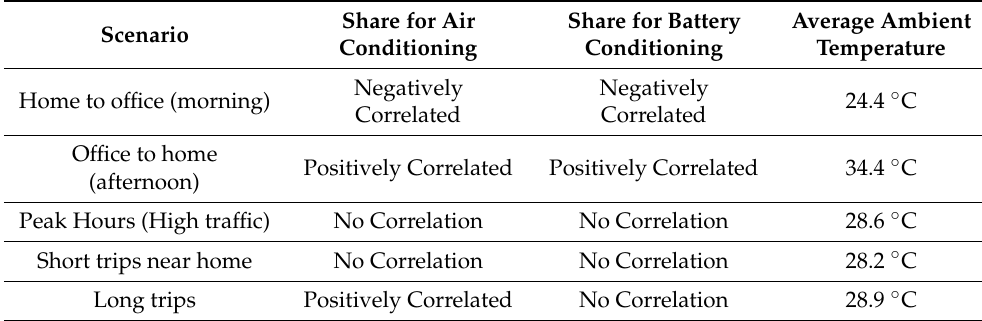
Table 5. Correlation between energy consumption and related parameters.